Question: Provide a one-line summary of what is displayed.
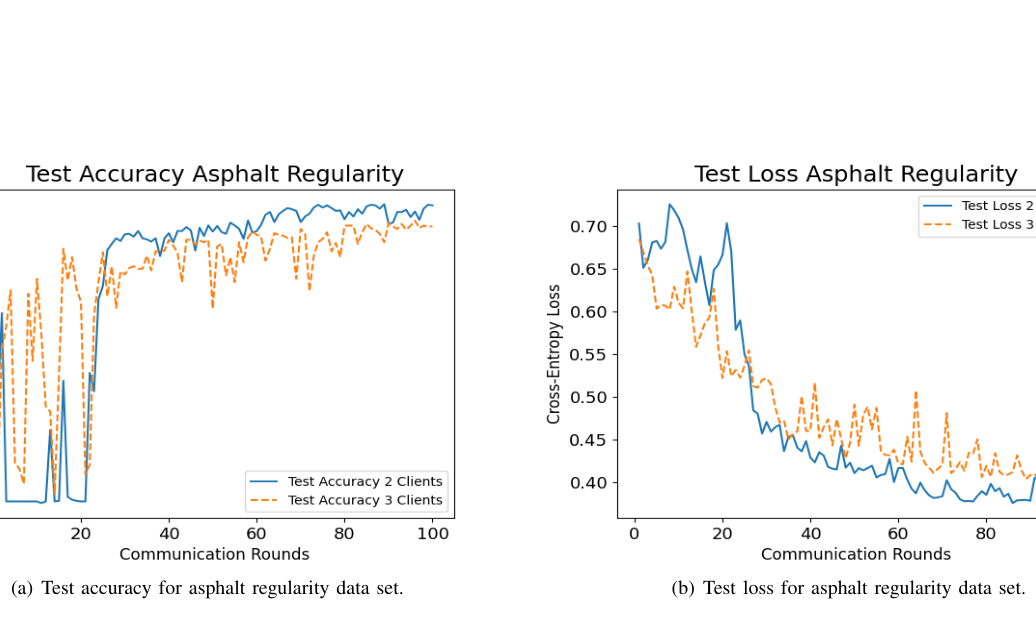
Answer: Performance of asphalt regularity data set.